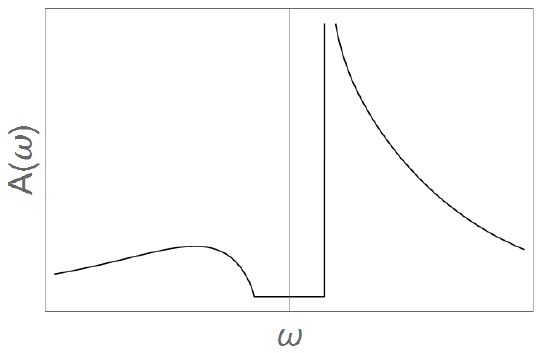
Figure 4: The plot of the spectral function A + ( ω ) . The parameters used to generate = 1, and γ = 0.8. the plot are p = 3, r = 0.2, ˜ v f